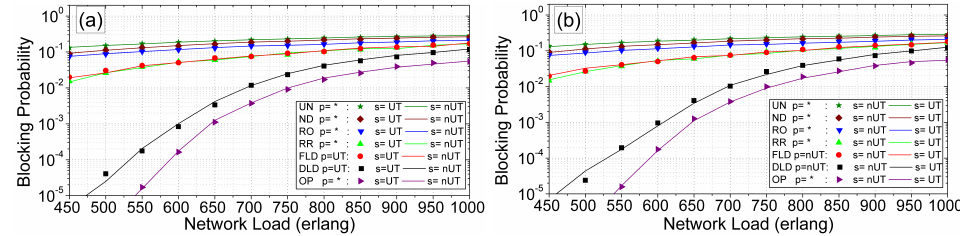
Figure 6. Blocking probability as a function of the total load in CoreNet topology using 1050 regener- ators and traffic: ( a ) uniform and ( b ) non